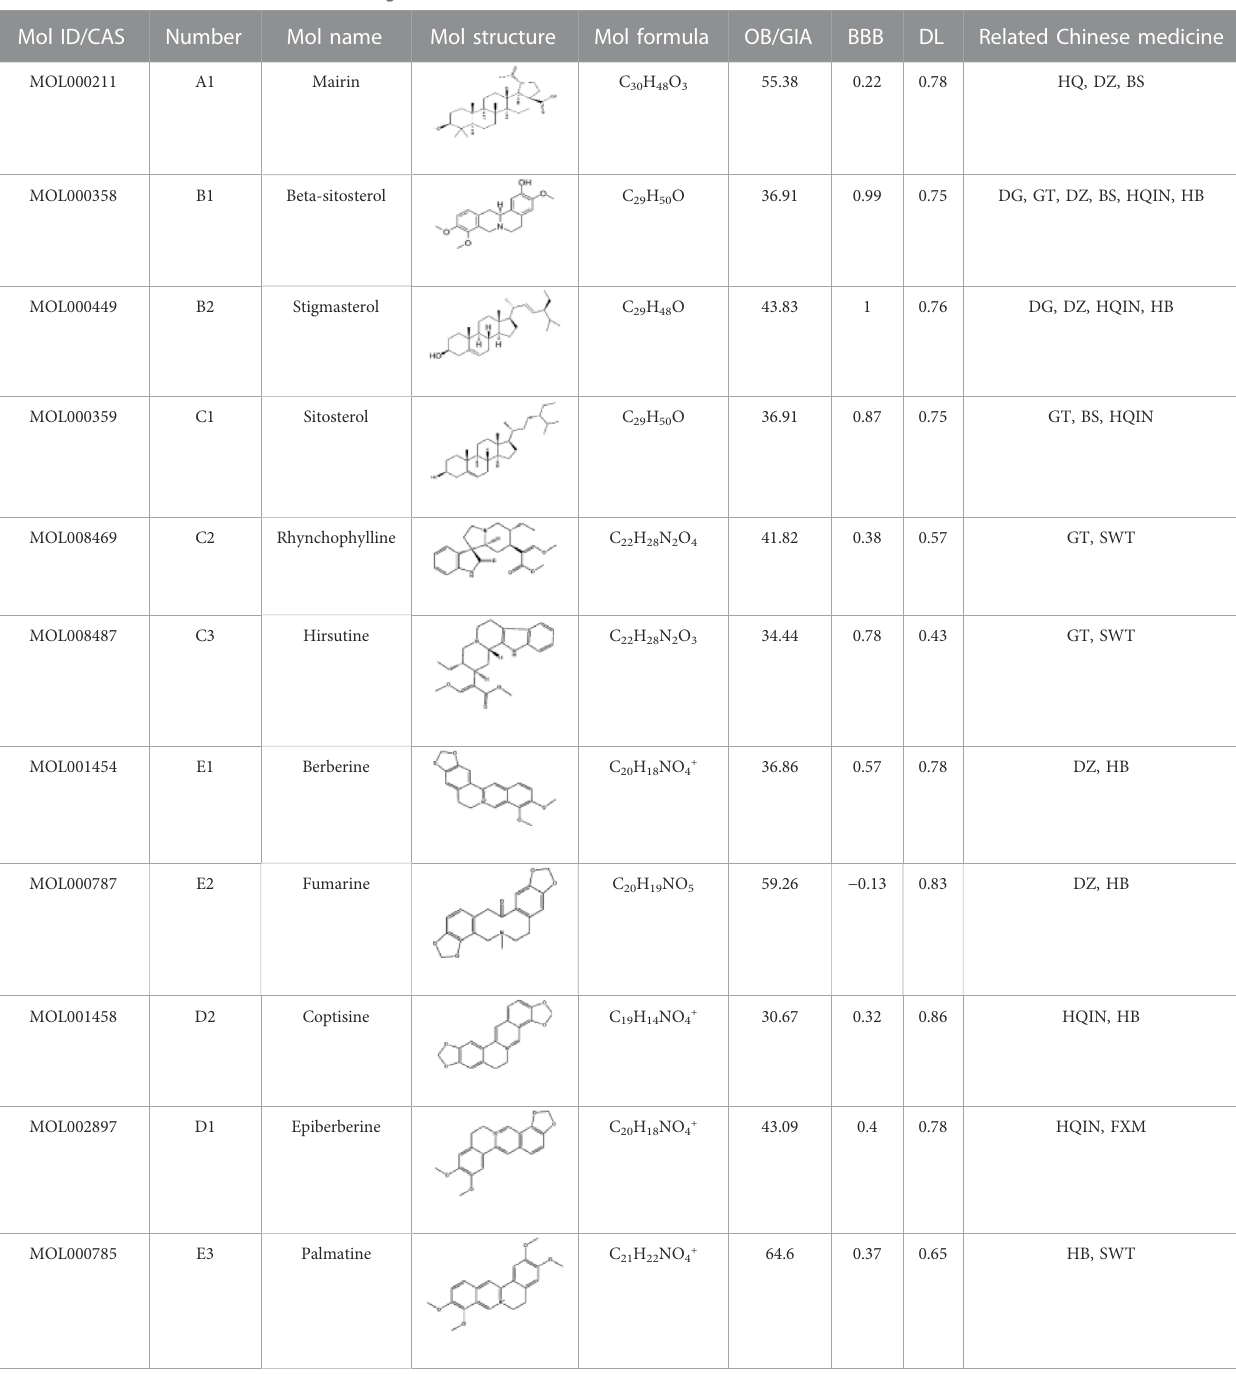
TABLE 4 Detailed information of shared active ingredients derived from